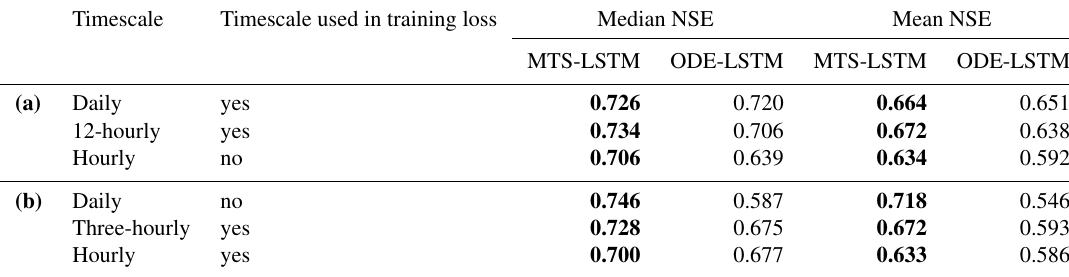
Table C1. Test period NSE for the MTS-LSTM and ODE-LSTM models trained on two and evaluated on three target timescales. (a) Training on daily and 12-hourly data, evaluation additionally on hourly predictions (hourly MTS-LSTM results obtained as 12-hourly predictions uniformly distributed across 12h). (b) Training on hourly and three-hourly data, evaluation additionally on daily predictions (daily MTS- LSTM predictions obtained as averaged three-hourly values). The mean and median NSE are aggregated across the results for 10 basins; best values are highlighted in